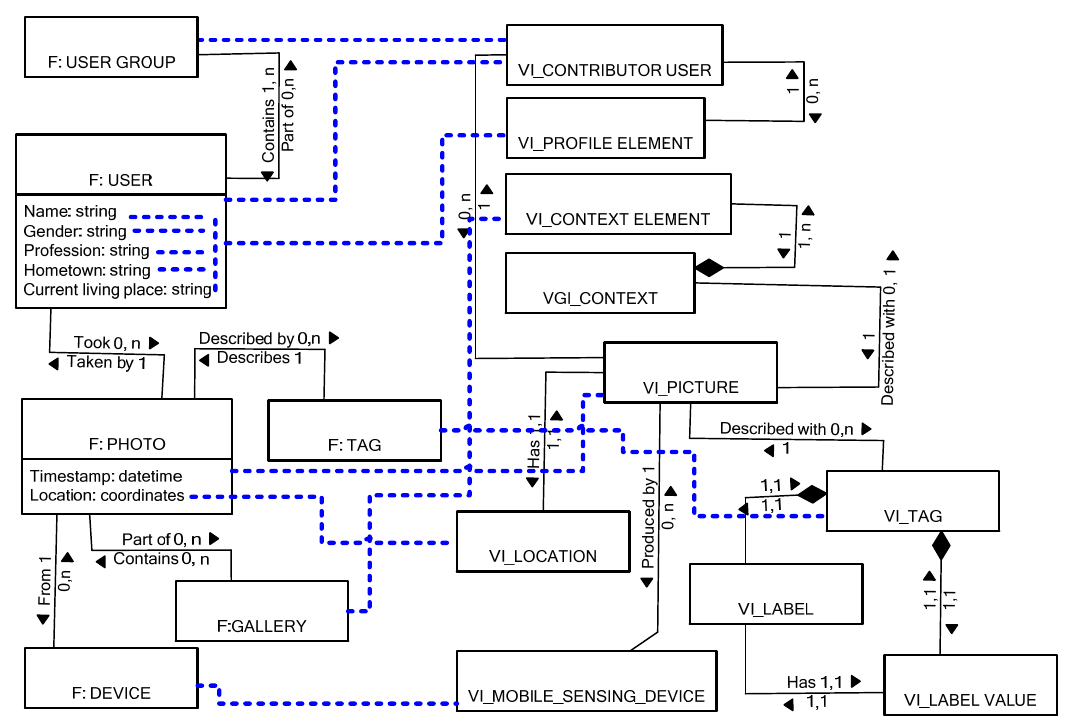
Figure 4. Example of mapping between a VGI application model (Flickr) and the VGI Semantic